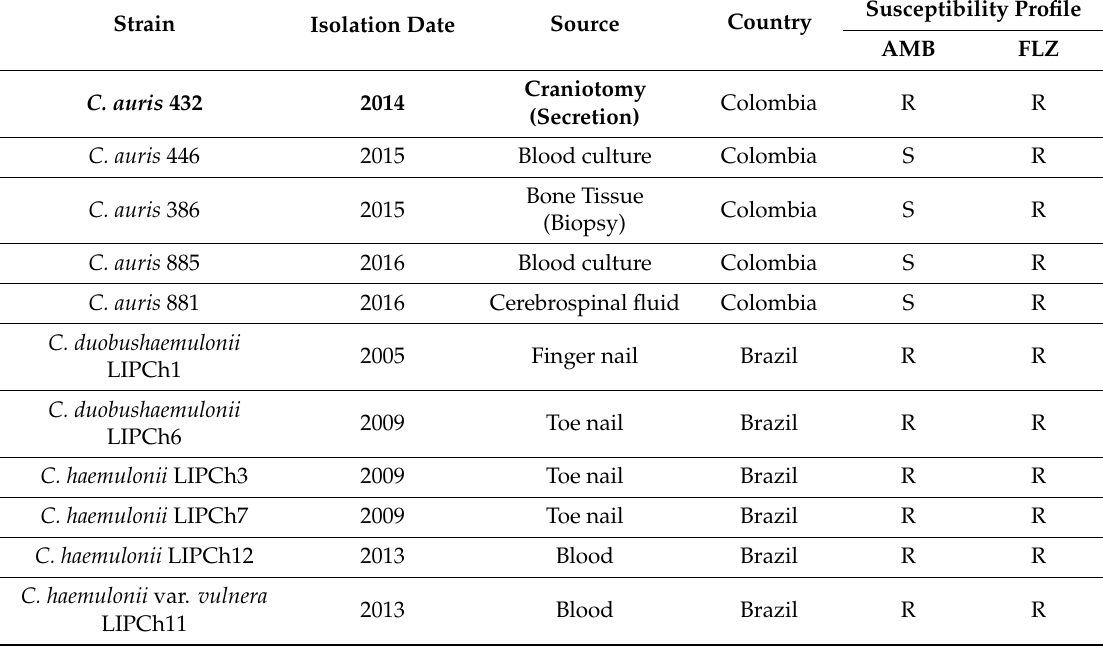
Table 1. Identification and antifungal susceptibility profiles of the C. haemulonii complex and C. auris strains included in this